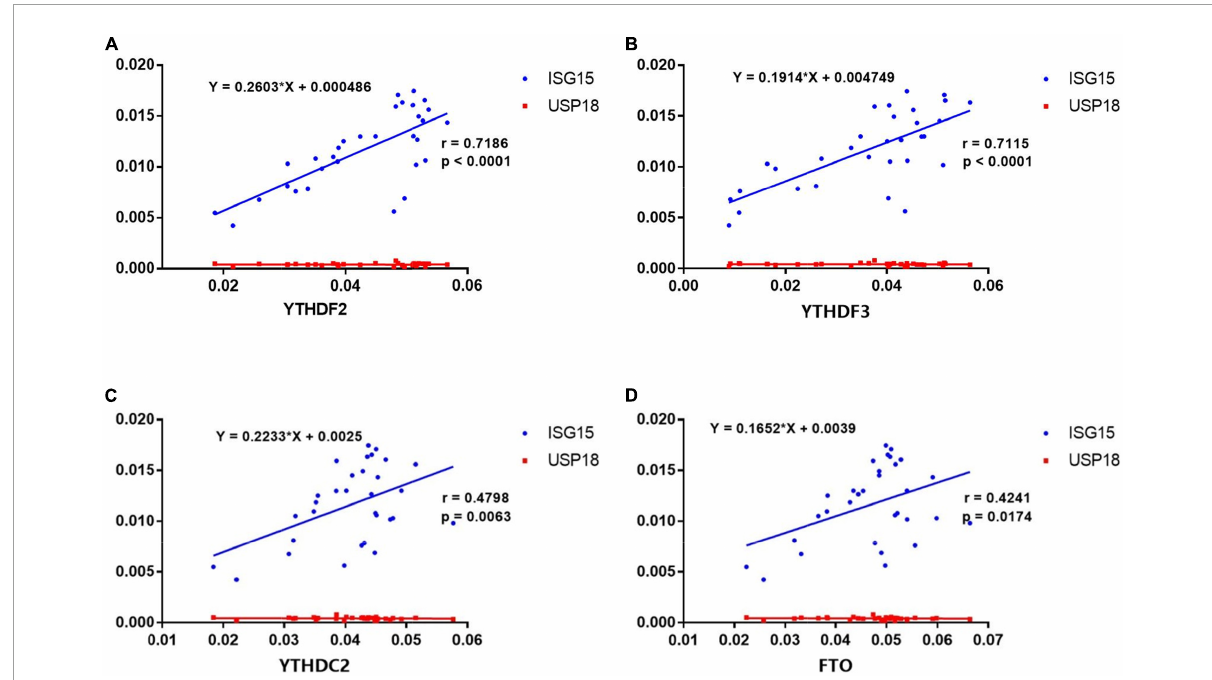
FIGURE6 Correlations between the expression of N6-methyladenosine (m6A)-related genes and interferon-stimulated genes (ISGs) in primary Sjögren’s syndrome (pSS). (A–D) ISG15 was positively correlated with YTHDF2, YTHDF3, YTHDC2, and FTO in pSS. USP18 was not correlated with YTHDF2, YTHDF3, YTHDC2, and FTO in pSS.